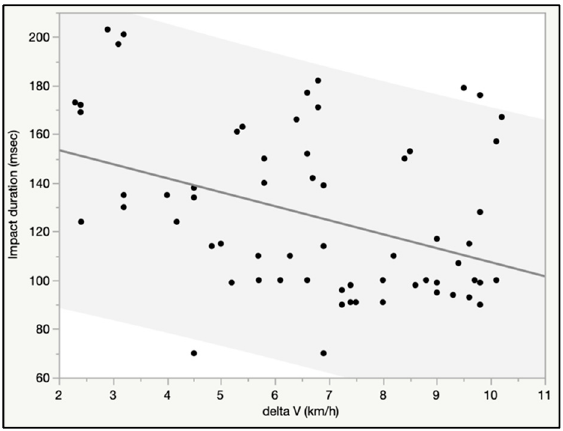
Figure 4. Impact duration (msec) vs. delta V (km/h) for 69 crash tests.